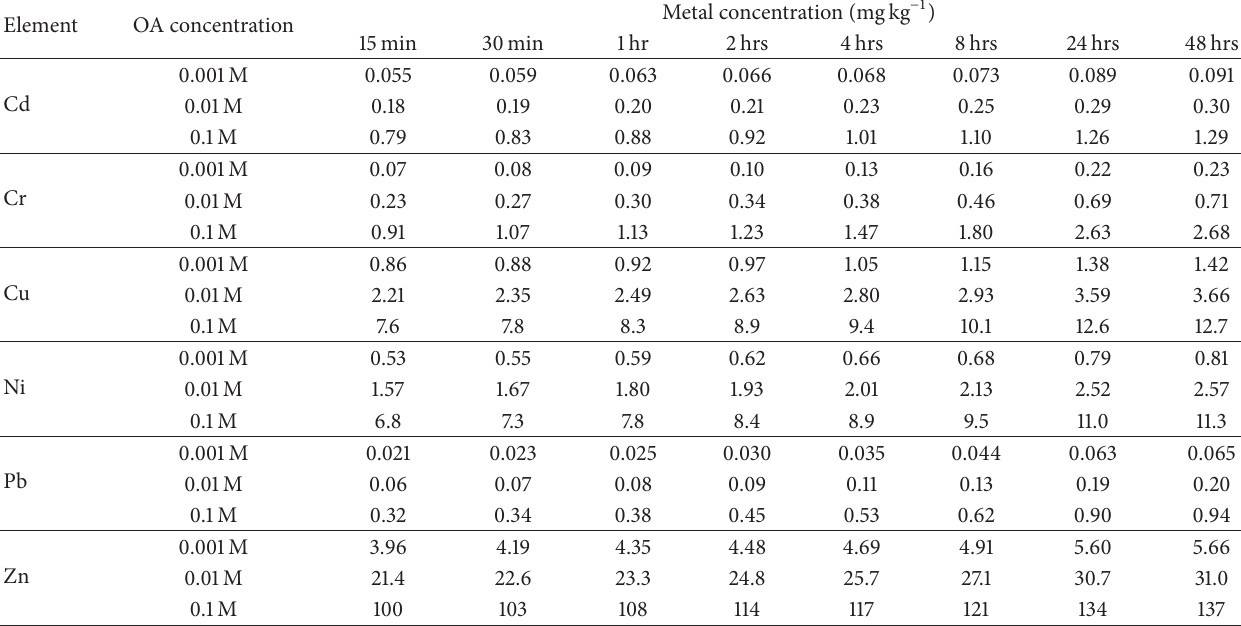
Table 7: Metals release kinetics of biosolid-treated Romona soil (135Mg ha −1 ) in different concentrations of organic acid (OA) mixtures. Element OA